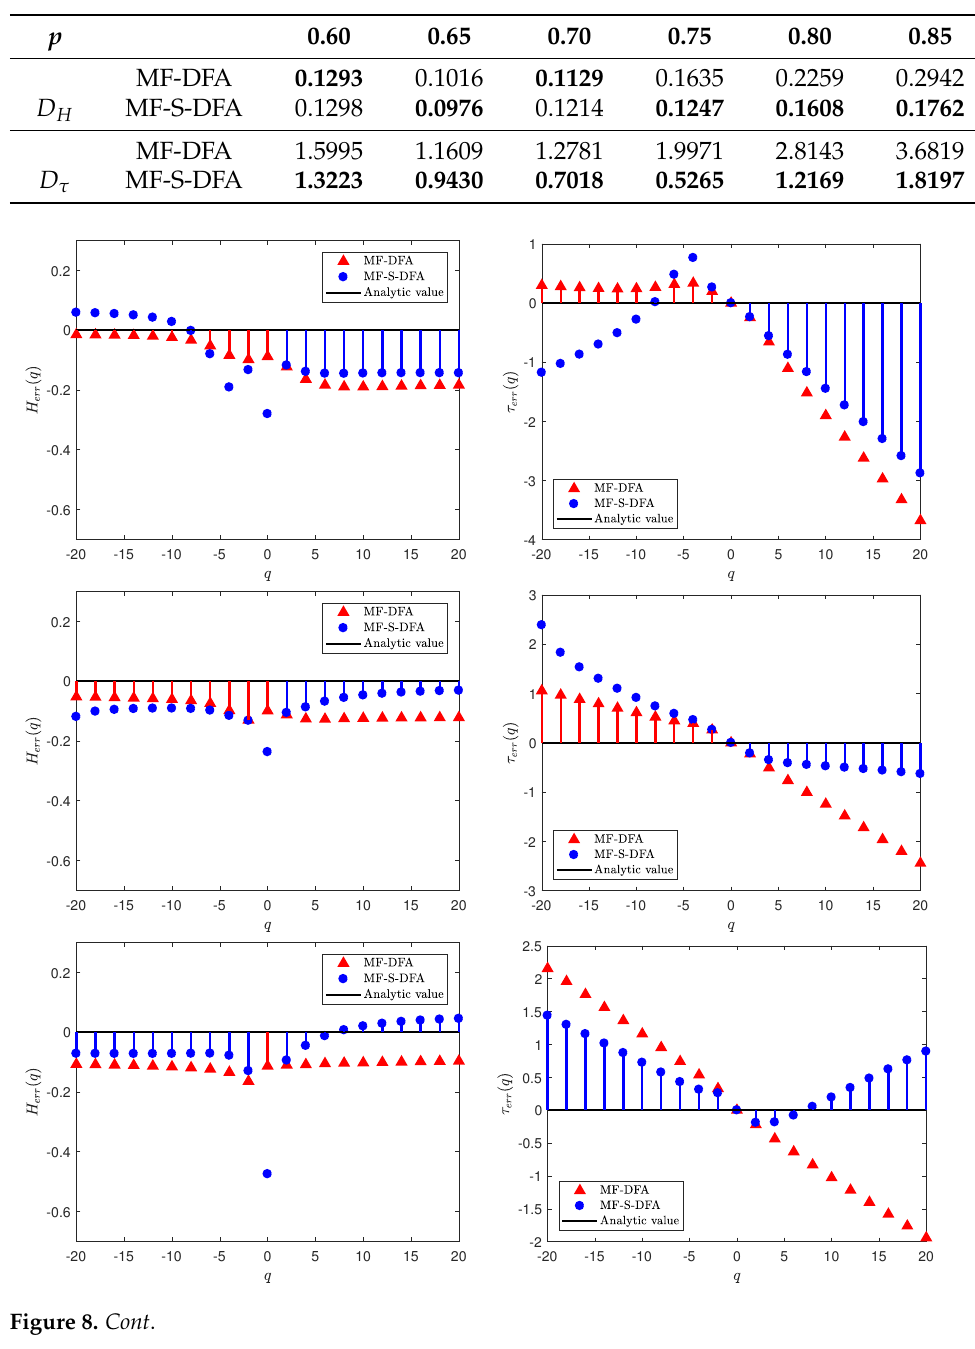
Table 3. D H and D τ for two methods with different values of p .